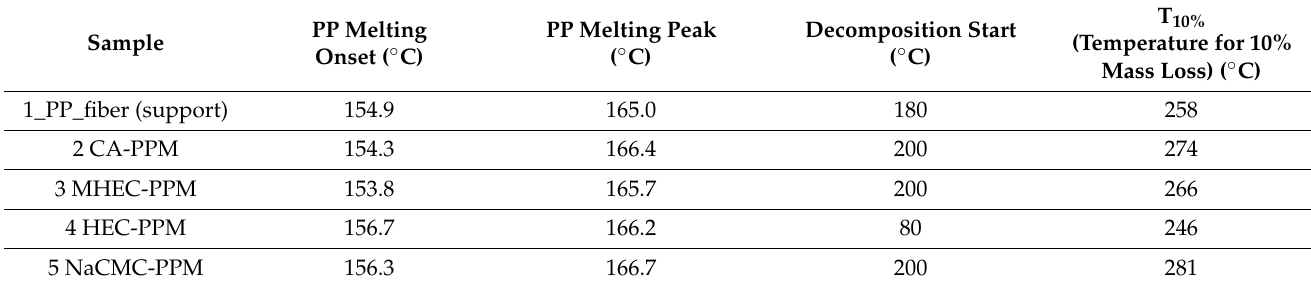
Table 5. Main thermal characteristics of the hollow fiber